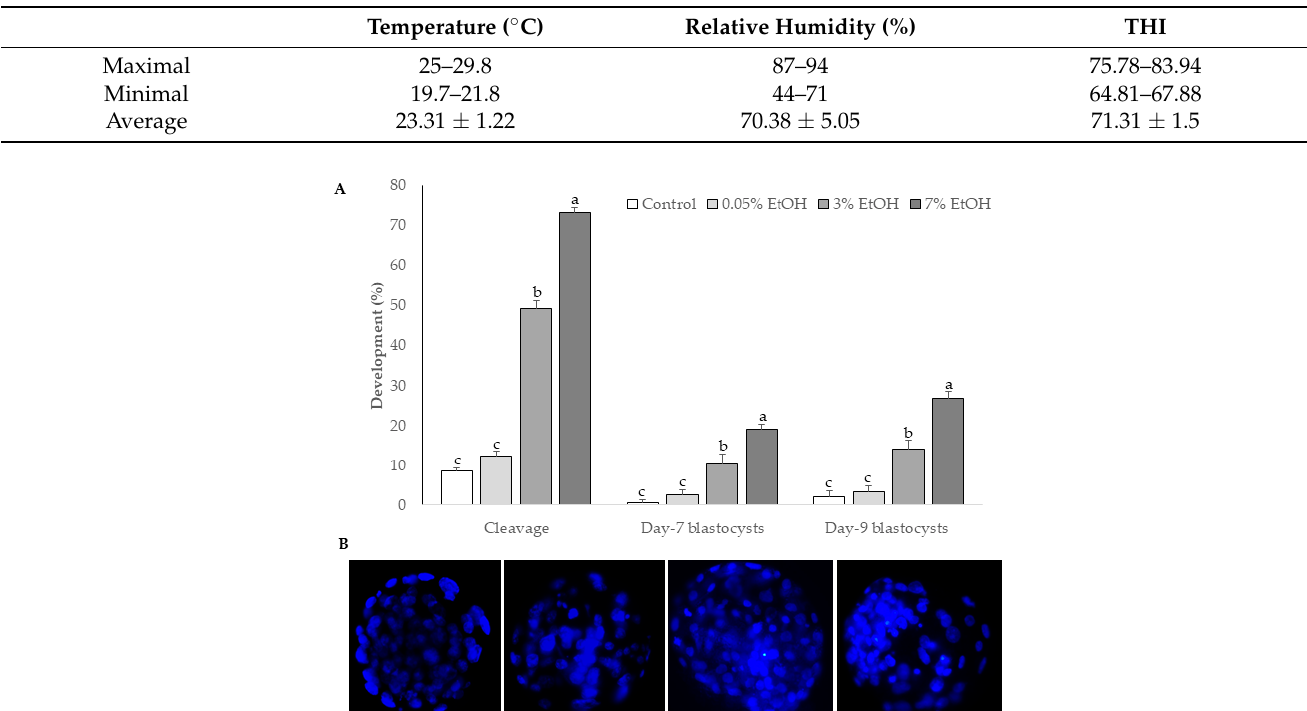
Table 2. Maximum, minimum and average ( ± s.e.m) values for temperature ( ◦ C), relative humidity (%) and temperature- humidity index (THI) recovered between 21 December 2020 to 9 March 2021 reported in the north of Uruguay.